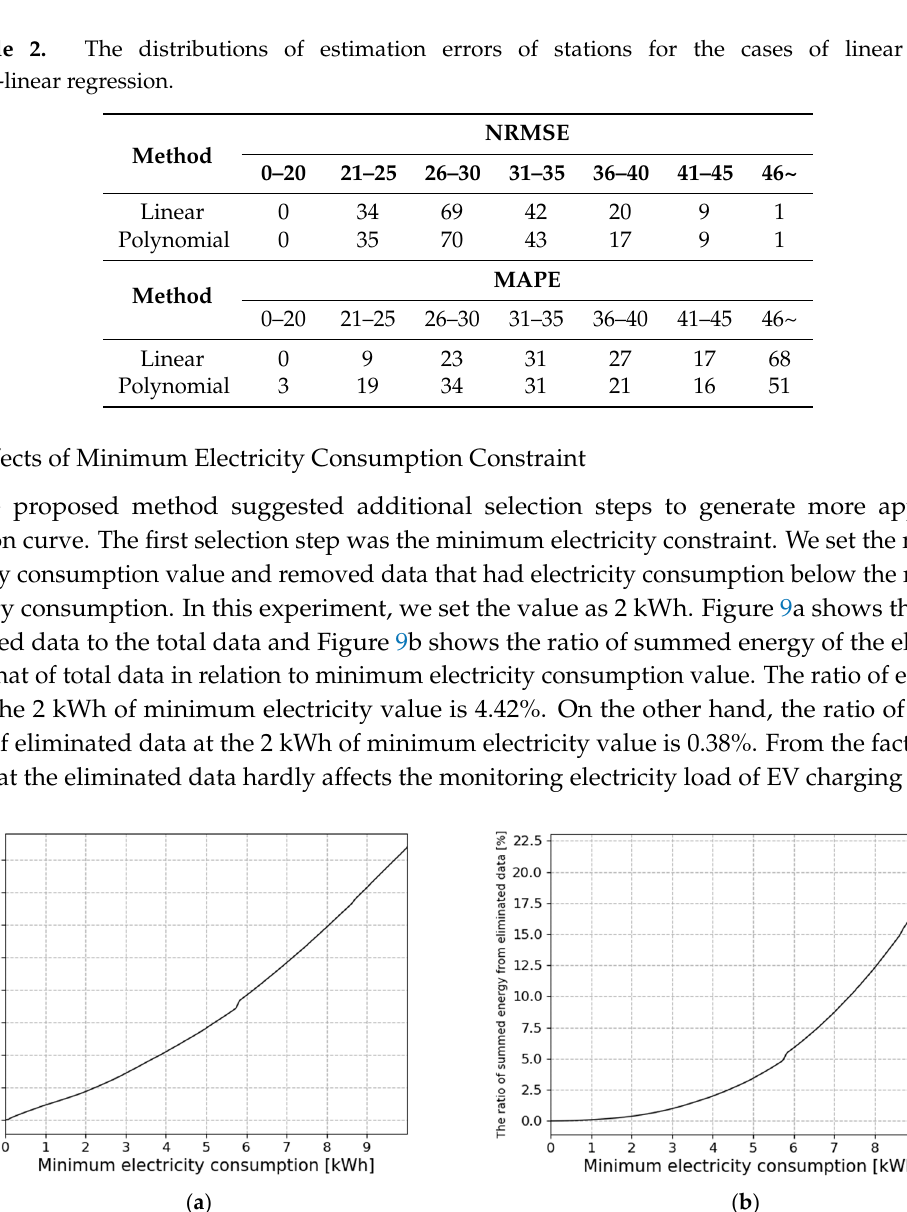
Table 3. The distributions of estimation errors of stations with and without minimum electricity consumption constraint. ‘No-constraints’ represents the case without the constraints and ‘Constraint’ represents the case with the constraint.